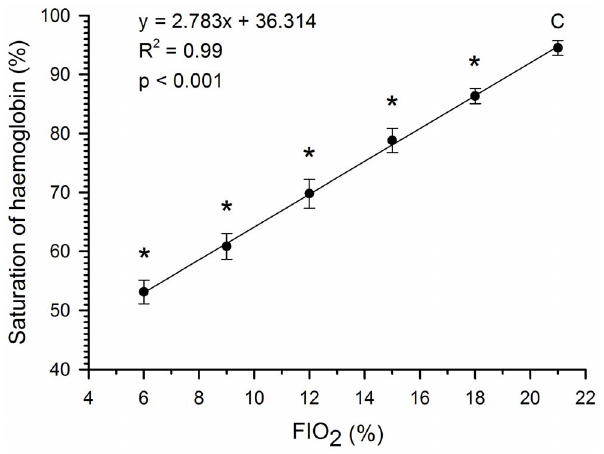
Figure 3. Oxygen saturation of haemoglobin as a function of FIO 2 . Values of haemoglobin oxygen saturation are measured after 3 minutes of exposure to a FIO2 and expressed as means 6 SD for the different FIO 2 values. Comparisons were made using a one-way ANOVA followed by Newman-Keuls test. *p , 0.05.